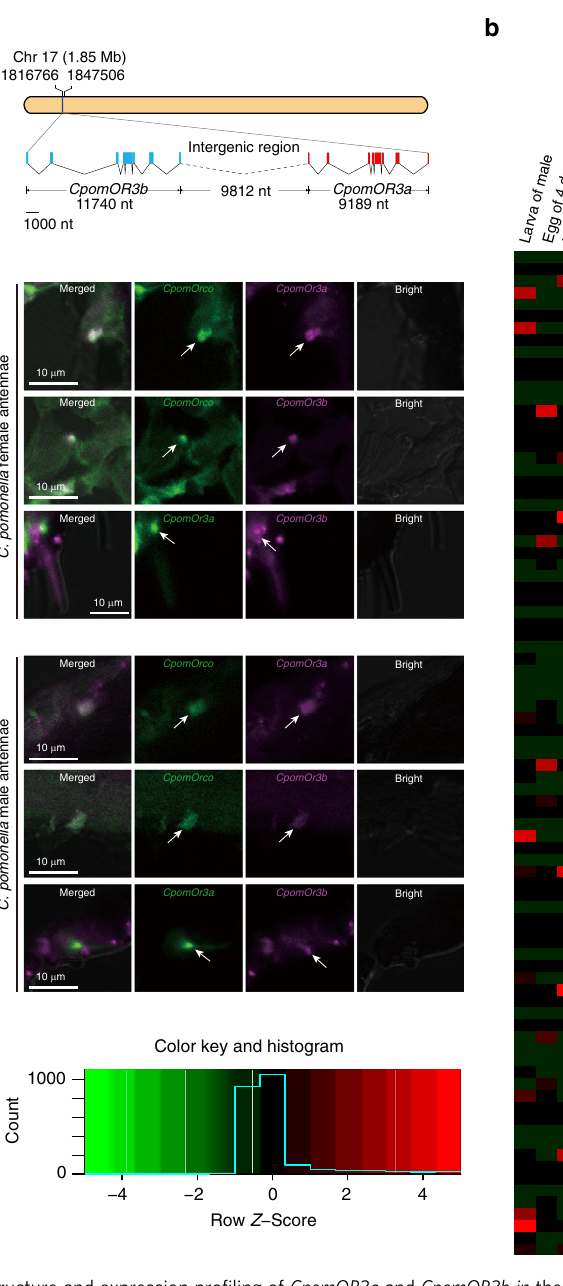
Fig. 3 Structure and expression pro fi ling of CpomOR3a and CpomOR3b in the codling moth, Cydia pomonella . a Exon – intron organization and chromosome location of CpomOR3a and CpomOR3b genes. The exon – intron organization of each gene was determined by sequence comparison between genomic sequences and putative cDNA sequences with BLASTN. The exons are shown as boxed regions ( CpomOR3b : blue; CpomOR3a : red). The angled solid lines between boxes indicate the introns, while the angled dotted lines indicate the intergenic region. b Expression pro fi ling of CpomOR3a and CpomOR3b in different tissues of C. pomonella . Estimation of abundance values determined by read mapping. Green indicates no to low expression, black indicates low to moderate expression, and red indicates moderate to high expression. Each data block shows the scaled z -score of FPKM value of the corresponded tissue/ organ. The NCBI SRA accession numbers of all used transcriptomes were given in Supplementary Table 27. c Co-expression patterns of CpomOR3a , CpomOR3b , and CpomORco in C. pomonella antennae. Two-color FISH was used to label each pair of genes by probes with either digoxigenin (green) or biotin (purple). Upper panels: Female antennae expression. Lower panels: Male antennae expression. For both sexes, row 1: co-expression of CpomORco and CpomOR3a ; row 2: co-expression of CpomORco and CpomOR3b ; row 3: separated expression of CpomOR3a and CpomOR3b . Source data are provided as a Source Data fi